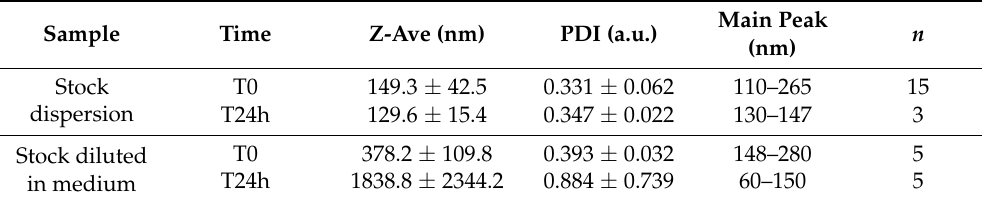
Table 1. Characterization of NM-300K directly after preparation (T0) and after 24 h (T24h). The stock dispersion (10 mg/mL) was used for aerosolized exposure and was diluted in LHC-9 culture medium to make a medium dispersion (141 µ g/mL, 100 µ g/cm 2 ) for submerged exposure. Results are presented as mean ± standard deviation or interval (lower value–higher value) from n = 3–15 independent experiments. PDI: polydispersity index, h: